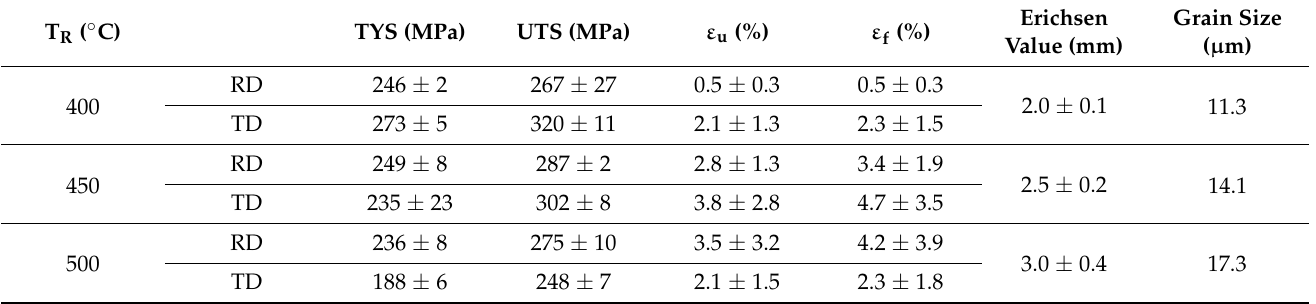
Table 2. Tensile properties at room temperature of the heat-treated sheets tested along RD, TD (TYS, tensile 0.2% yield stress; UTS, ultimate tensile stress; ε u , uniform elongation; ε f , elongation to frac- ture).